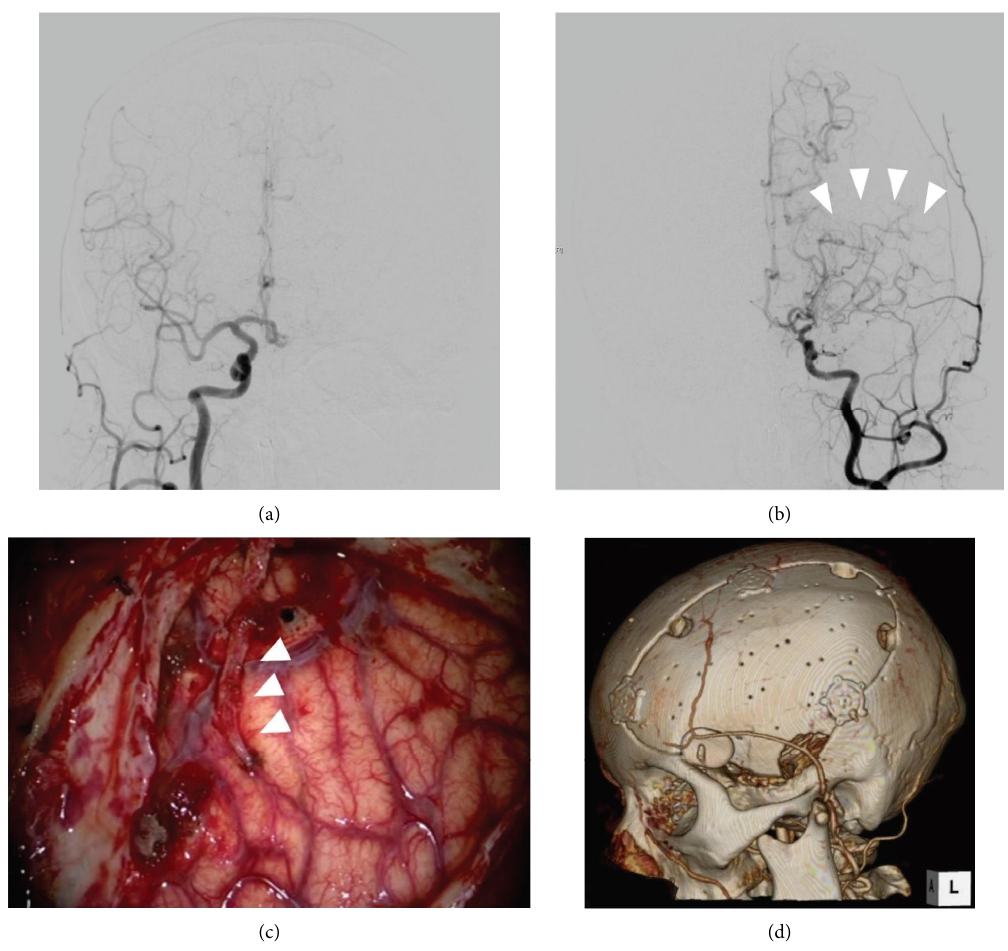
Figure 3: Images after initial procedure. (a) Digital subtraction angiography (DSA) of the right common carotid artery (CCA) after the initial surgery showing no remarkable abnormality. (b) DSA of the left CCA showed stenosis of the middle cerebral artery and moyamoya vessels (arrowheads). (c) Intraoperative photograph demonstrating encephalo-arterio-synangiosis between the brain surface and the parietal branch of the superfcial temporal artery (STA) (arrowheads). (d) Tree-dimensional computed tomography after the second surgery showing the structure of the implanted bone fap and